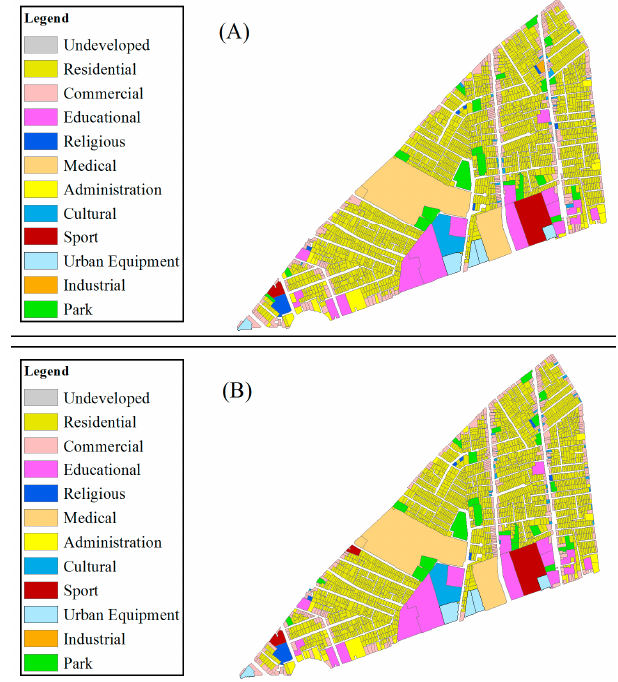
Figure 9. Land-use arrangements. ( A ) The output of the proposed land-use allocation process. ( B ) The output of the GA.